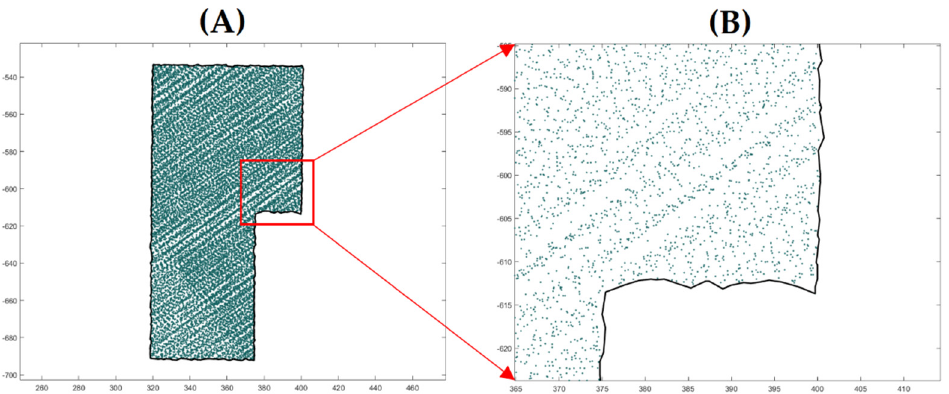
Figure 1. ( A ) The point cloud of a building and its derived initial outline. ( B ) The magnified view of the initial outline.